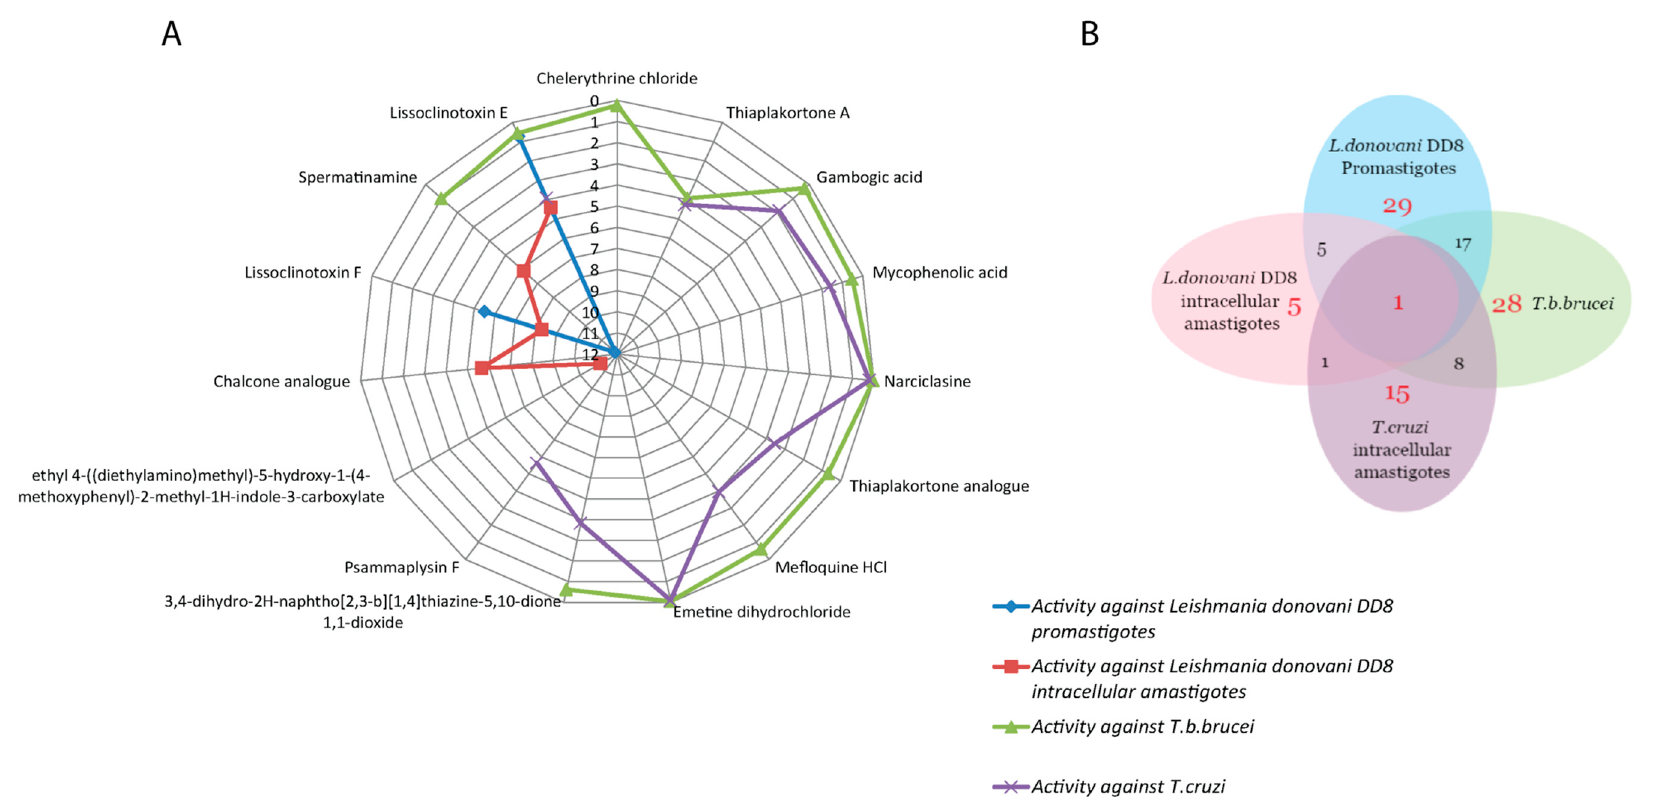
Figure 2. ( A ) Spider plot displaying the IC 50 values of compounds for L. donovani DD8 promastigotes, L. donovani DD8 intracellular amastigotes, T. b. brucei and T. cruzi ; ( B ) Venn diagram for overlapping active hits identified against L. donovani DD8 promastigotes, L. donovani DD8 intracellular amastigotes, T. b. brucei and T. cruzi .